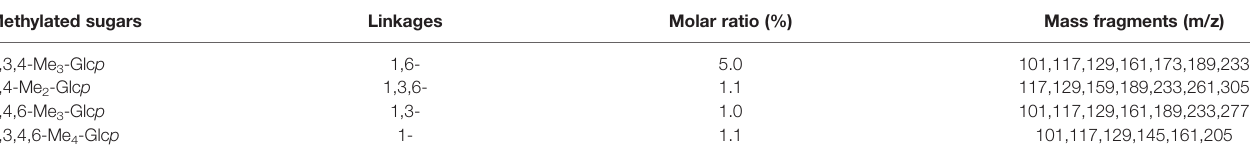
TABLE 2 | Glycosidic linkages analysis of APEP-A-b by GC – MS. Methylated